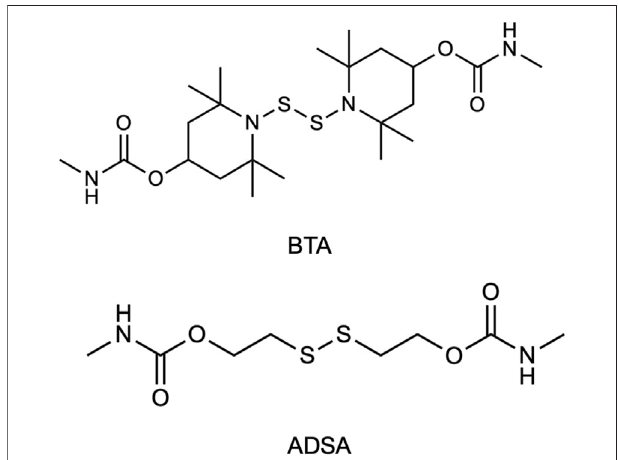
FIGURE 3 | Molecular models of the BTA and ADSA materials used in the quantum chemical